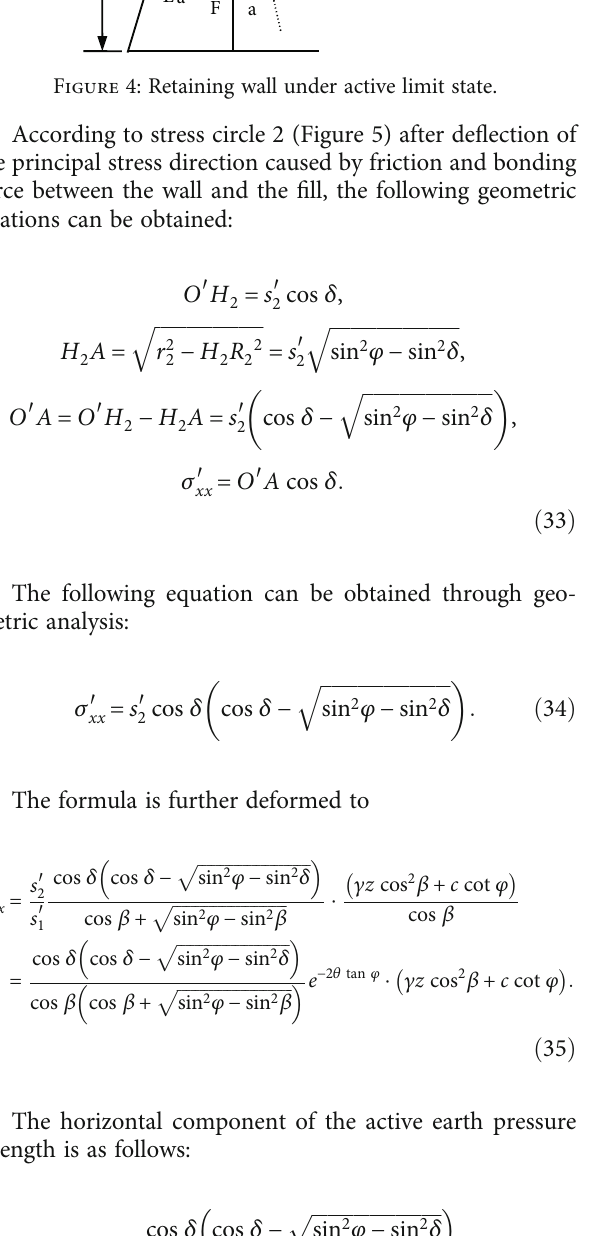
p(cid:5) ffiffiffiffiffiffiffiffiffiffiffiffiffiffiffiffiffiffiffiffiffiffiffiffiffi sin 2 φ − sin 2 δ